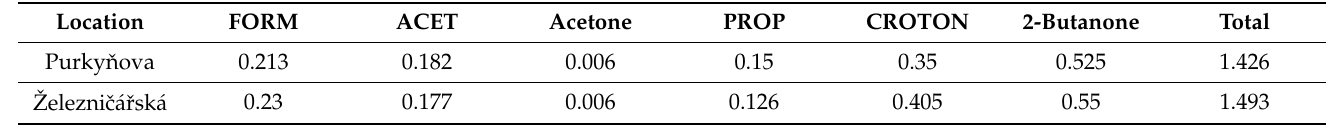
Table 11. Hazard Index of aldehydes near the oil processing plant in Stˇrekov- Ú st í nad Labem